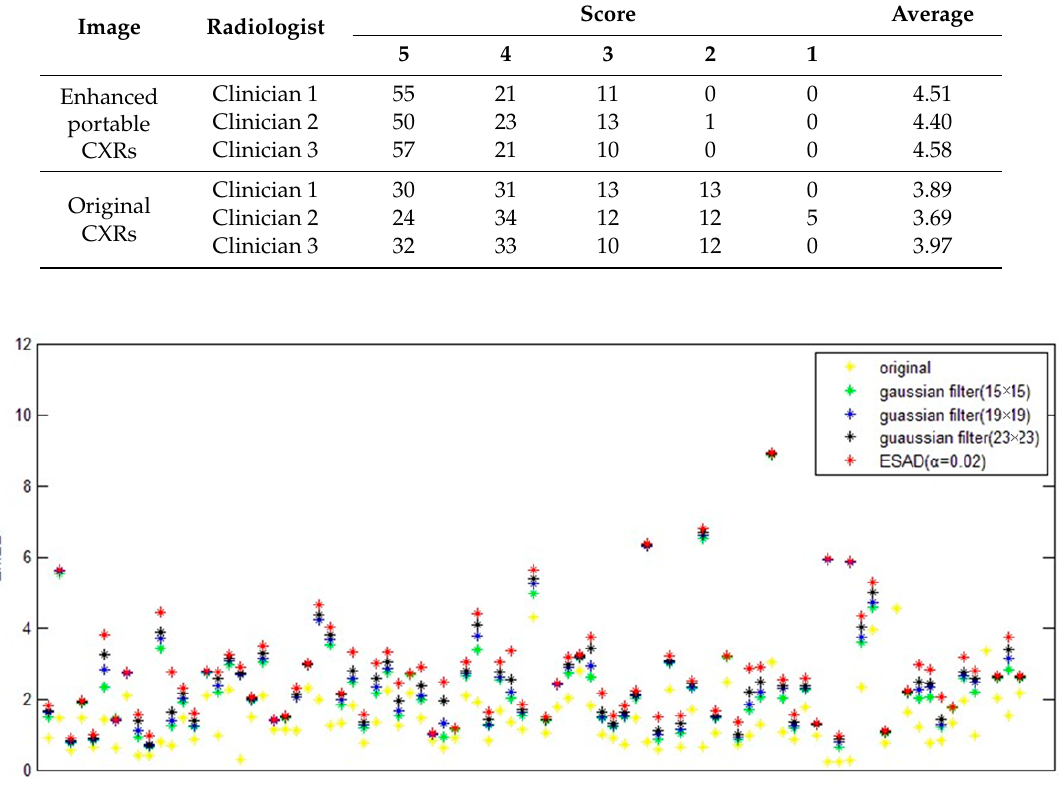
Figure 6. the EMEE value for the original images, results of our method and USM model, respectively, the kernel sizes of Gaussian filter are 15 × 15, 19 × 19, 23 × 23. Genes 2019 , 10 , 319